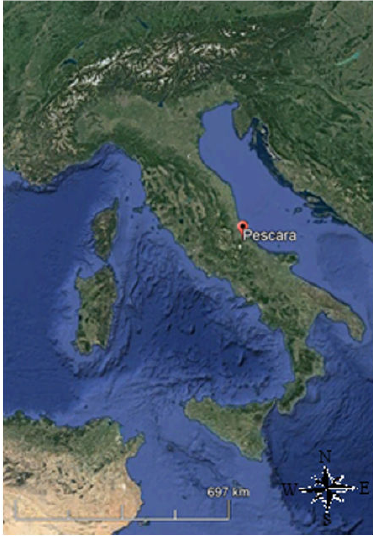
Figure 1. Map of Italy in which the study site of the Pescara Harbour is indicated by a red